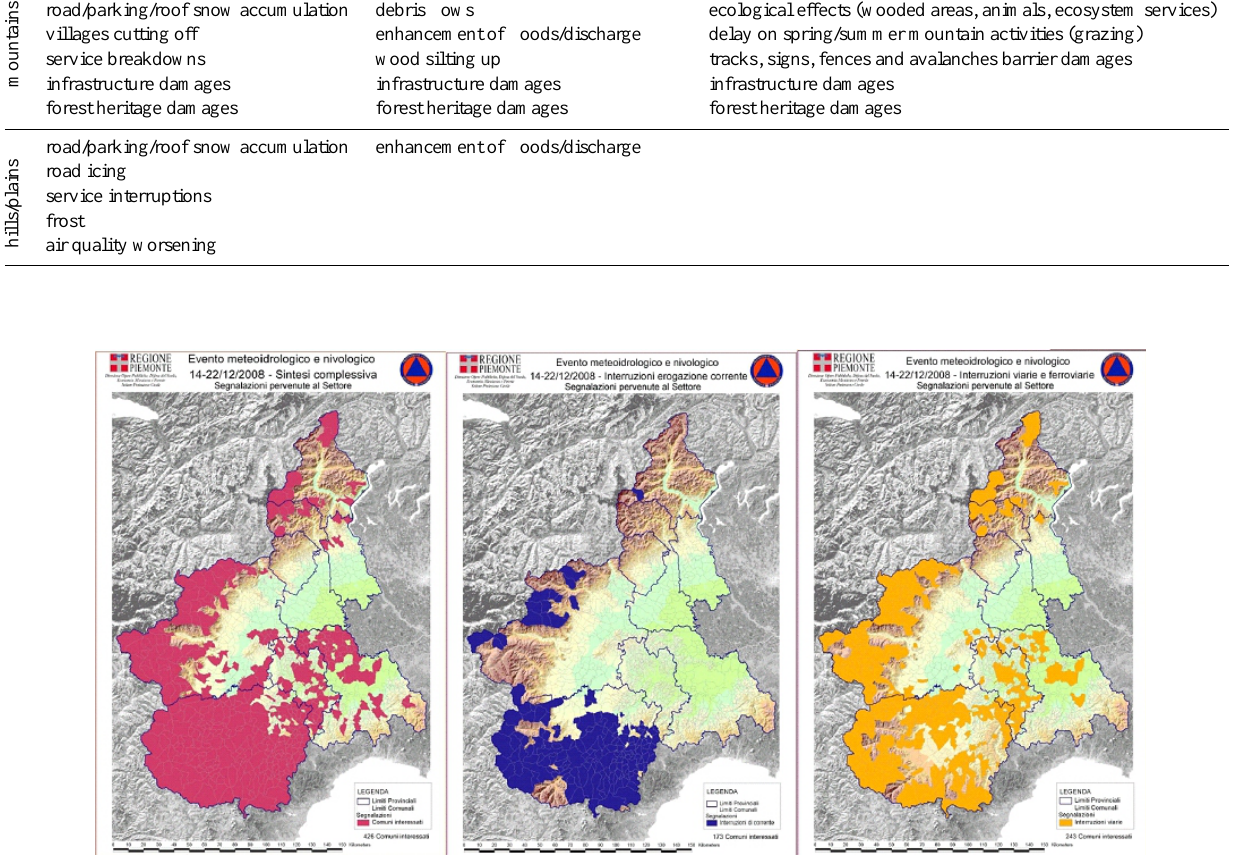
Figure 4. The territorial distribution of the damages (pink), power services breakdowns (blue) and road interruptions (yellow) caused by the 14–22 December 2008 snowfalls.